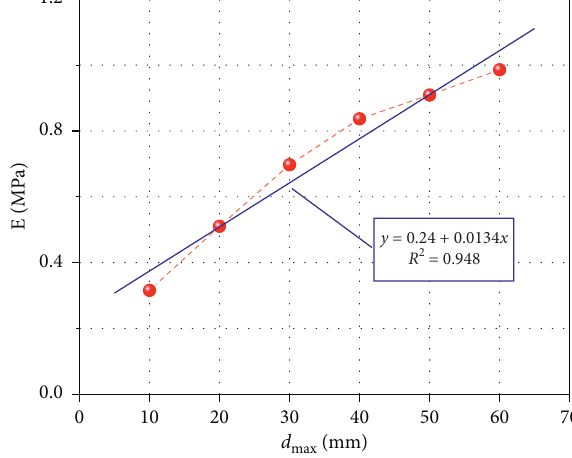
Figure 13: The relationship between E and d